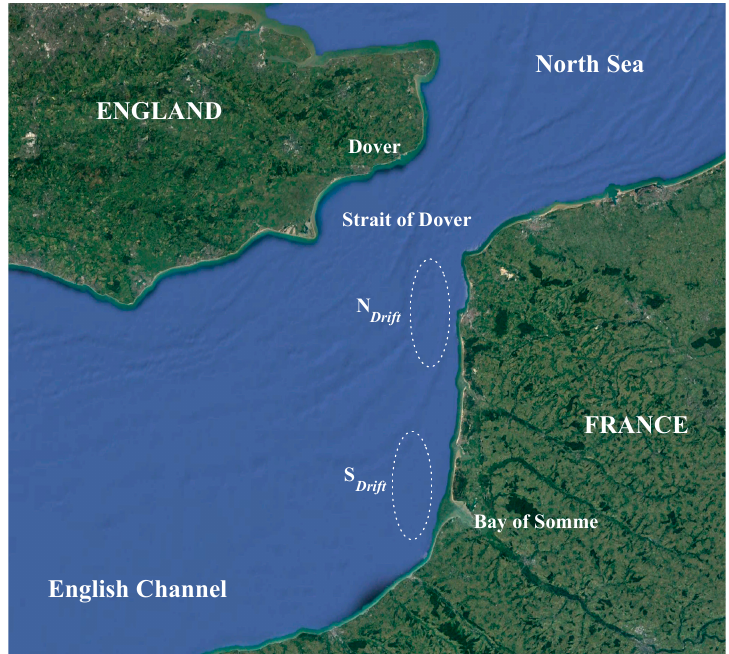
Figure 5. Field site and location of the drift area in the northern (N drift ) and southern (S drift ) part of the eastern English Channel.